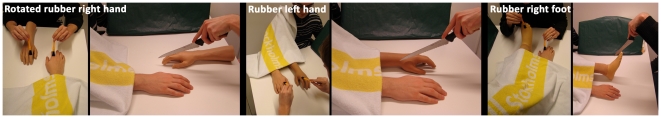
Control conditions.Set-ups used for the three different control conditions used in experiments 1, 3 and 4. The application of the brushstrokes on the real and artificial limbs is demonstrated in the left picture of each picture pair; to the right, the procedure of threatening the rubber limb with the knife is depicted. From left to right: the rotated rubber right hand, rubber left hand and rubber right foot conditions.